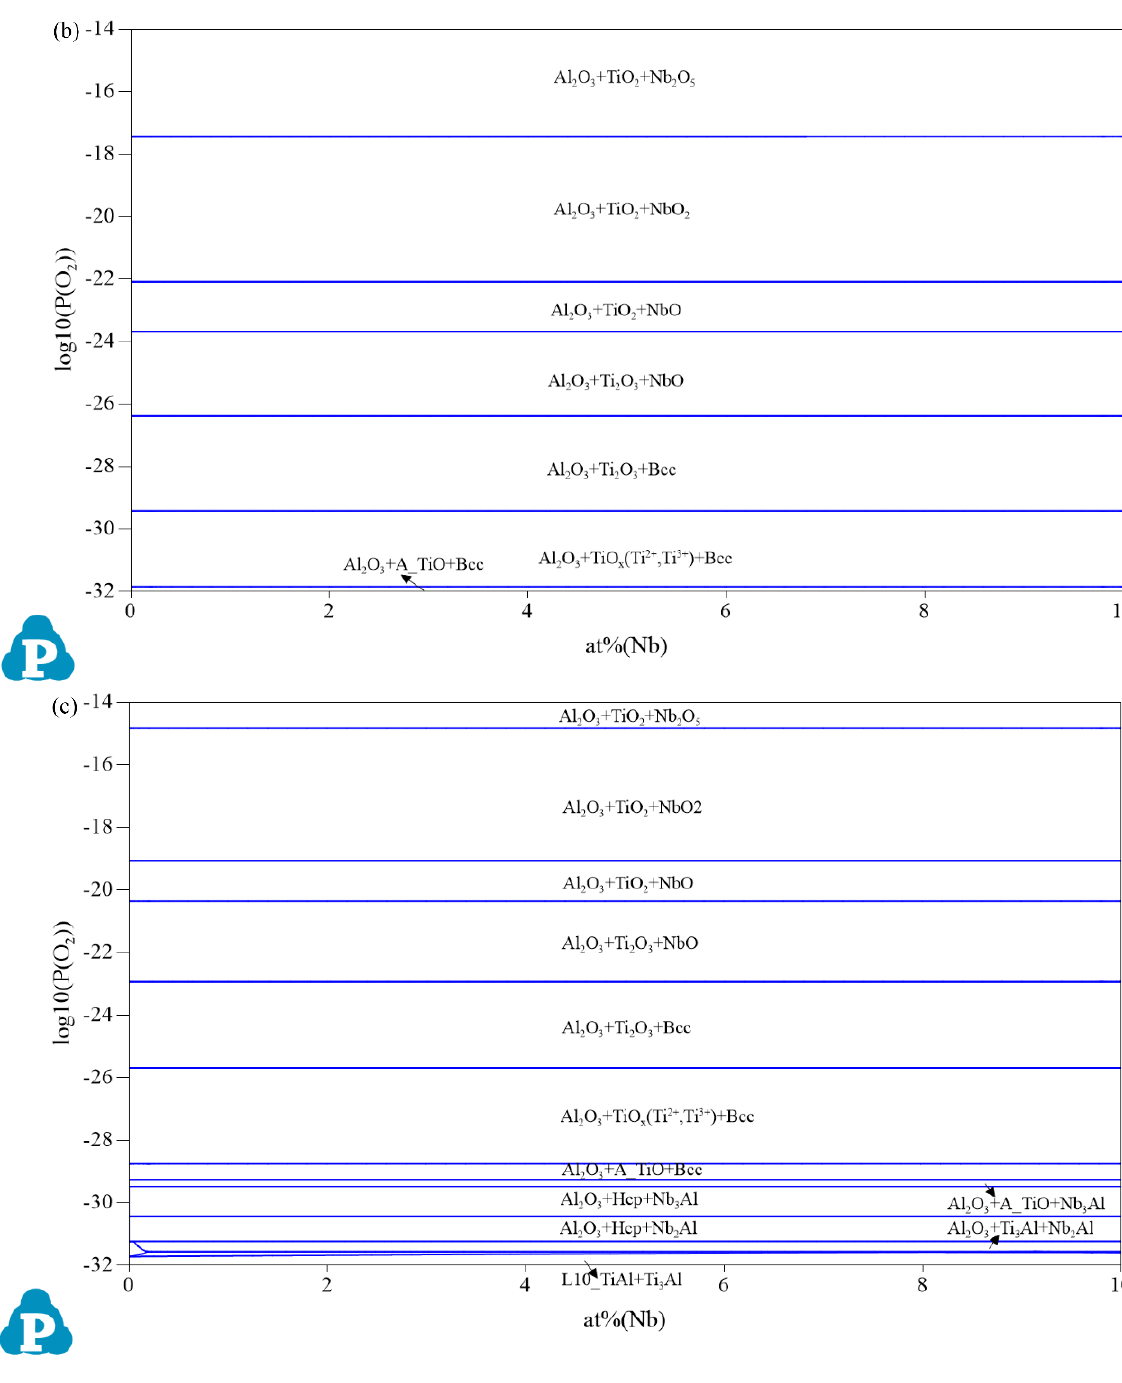
Figure 3. Initial oxidation products of Ti-48Al-xNb alloy at 700 °C ( a ), 800 °C ( b ), and 900 °C ( c ).